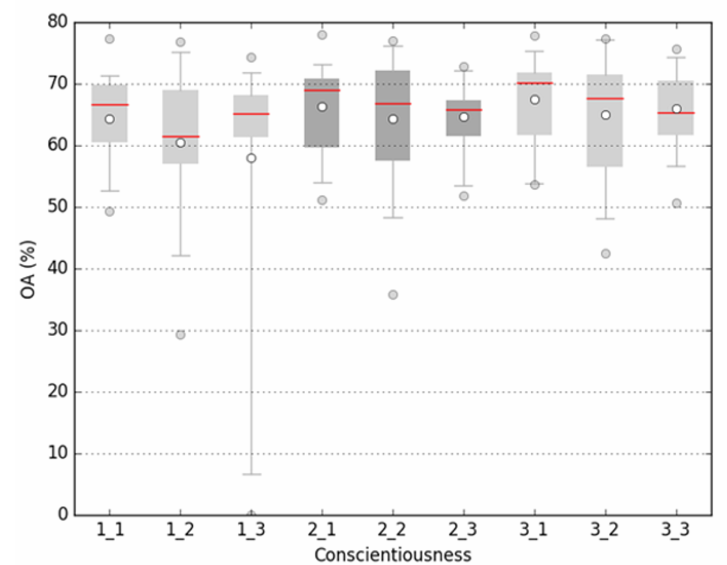
Figure 7. Boxplots of overall accuracies depending on iteration and group for extraversion, neuroticism and conscientiousness. The x-axis ticks are formatted as X _ Y with X the iteration number and Y group number. Median OA: red stripe; average OA: white dot; boxplot ends: first and third quantile; whiskers: + / − the 1.5-fold interquartile range on OA values and outliers: grey dots.